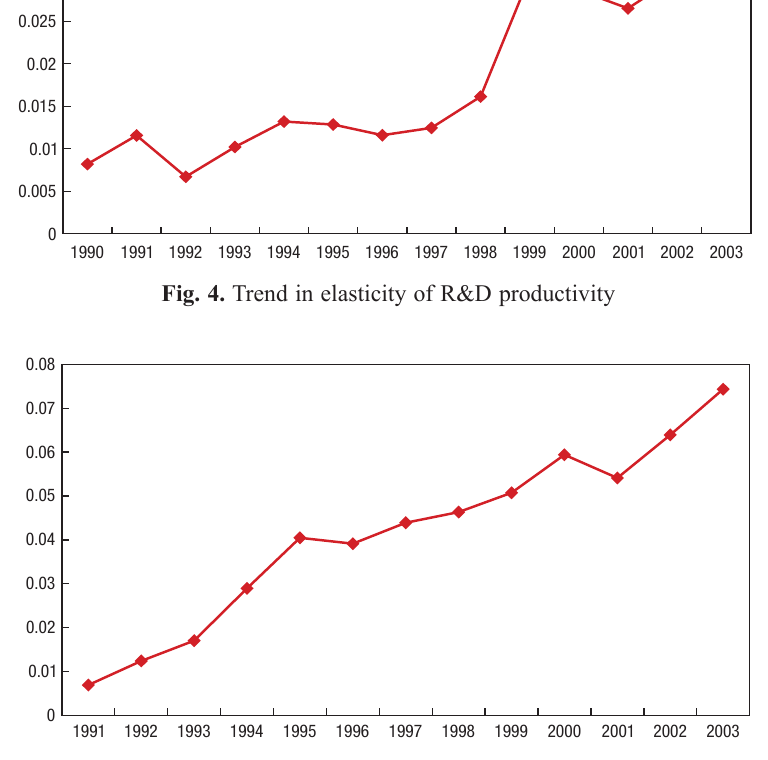
Fig. 5. The year differences on R&D